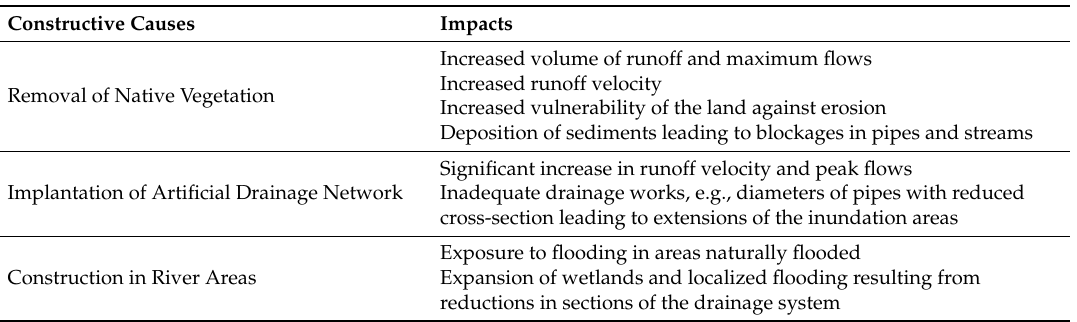
Table 1. Constructive causes and associated